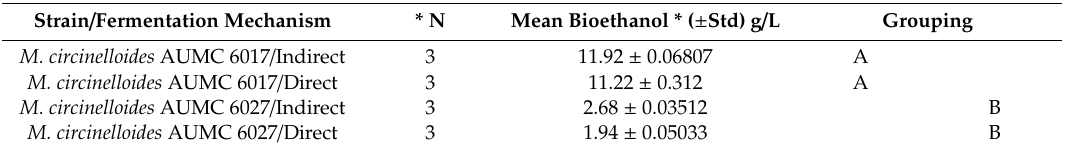
Table 4. Bioethanol production by two Mucor circinelloides strains using the one-step extracted Periplaneta americana chitin as a